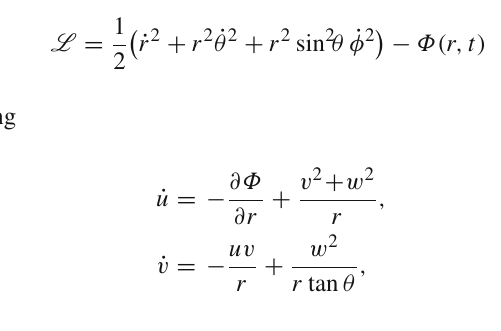
Here ρ( r , t ) is the mass density; if m (cid:4) denotes the stellar mass, we get the particle density n = ρ/ m (cid:4) . The Euler-Lagrange equations of motion corresponding to the Lagrange